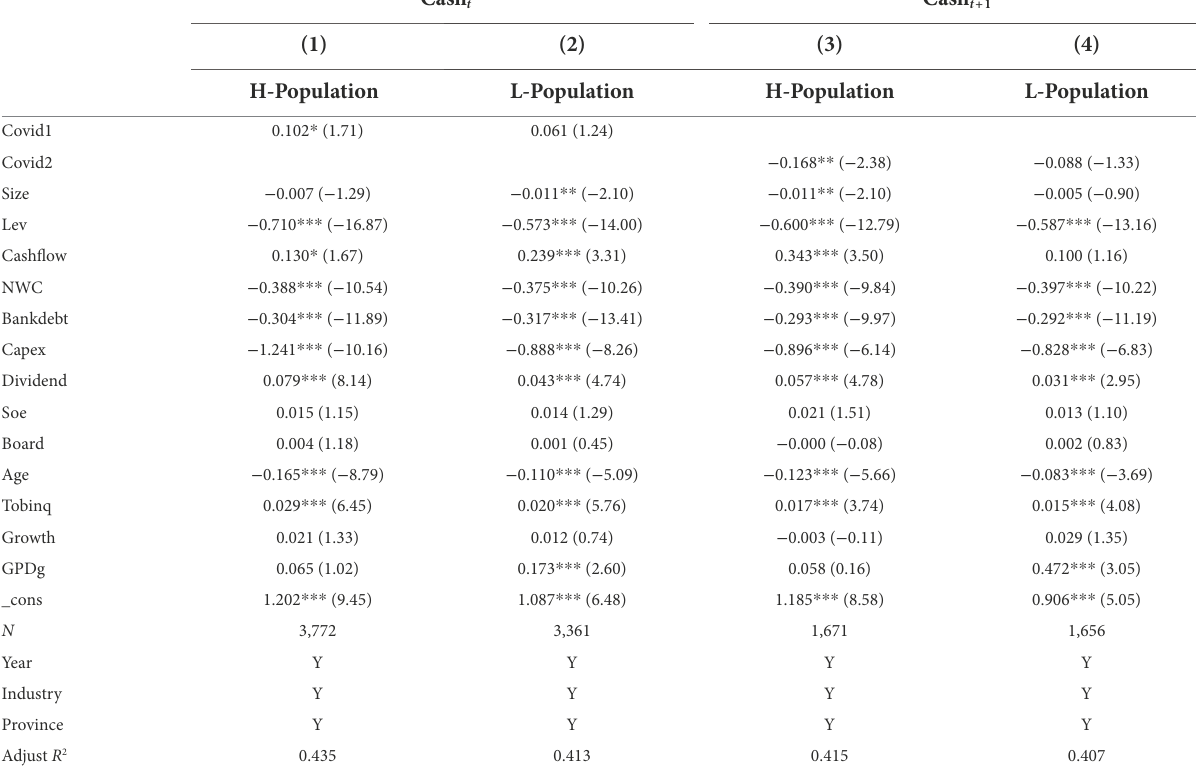
TABLE 13 COVID-19 impact and corporate cash holdings: based on population